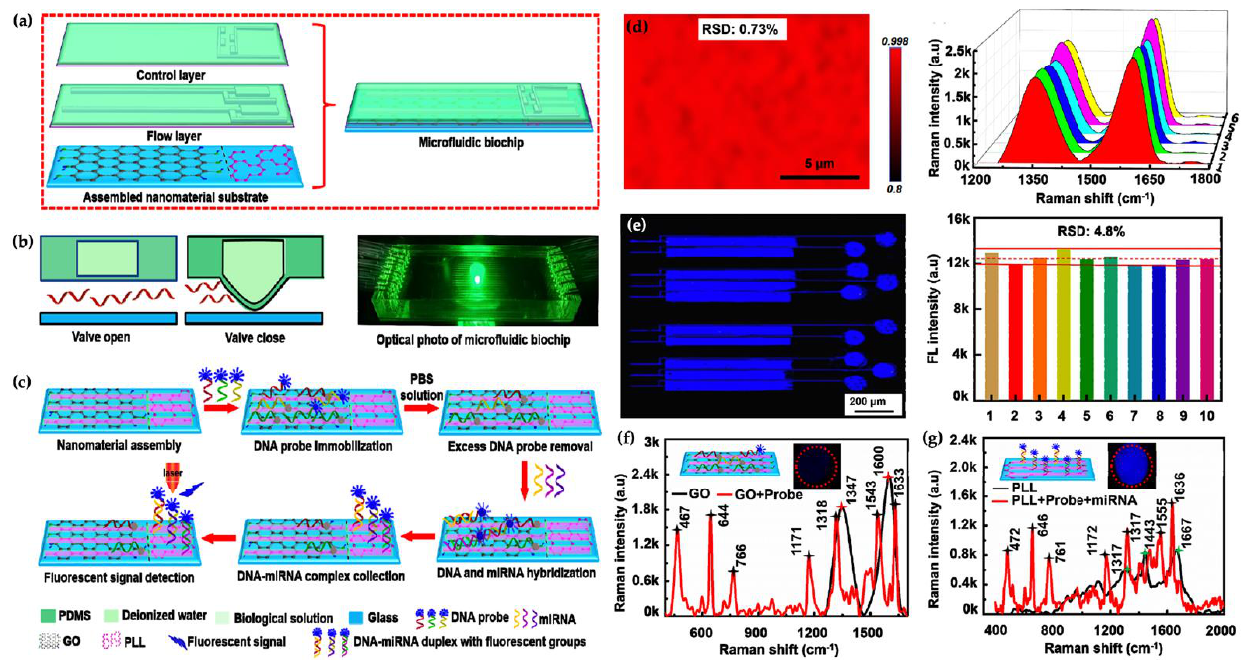
Figure 3. İllustration of the microfluidic chip; and the Raman mapping and representative ( a – c ) was also used to indicate all areas of interest and were assembled with graphene oxide (GO). ( d – g ) shows the fluorescence mapping images of the detection chamber [81].